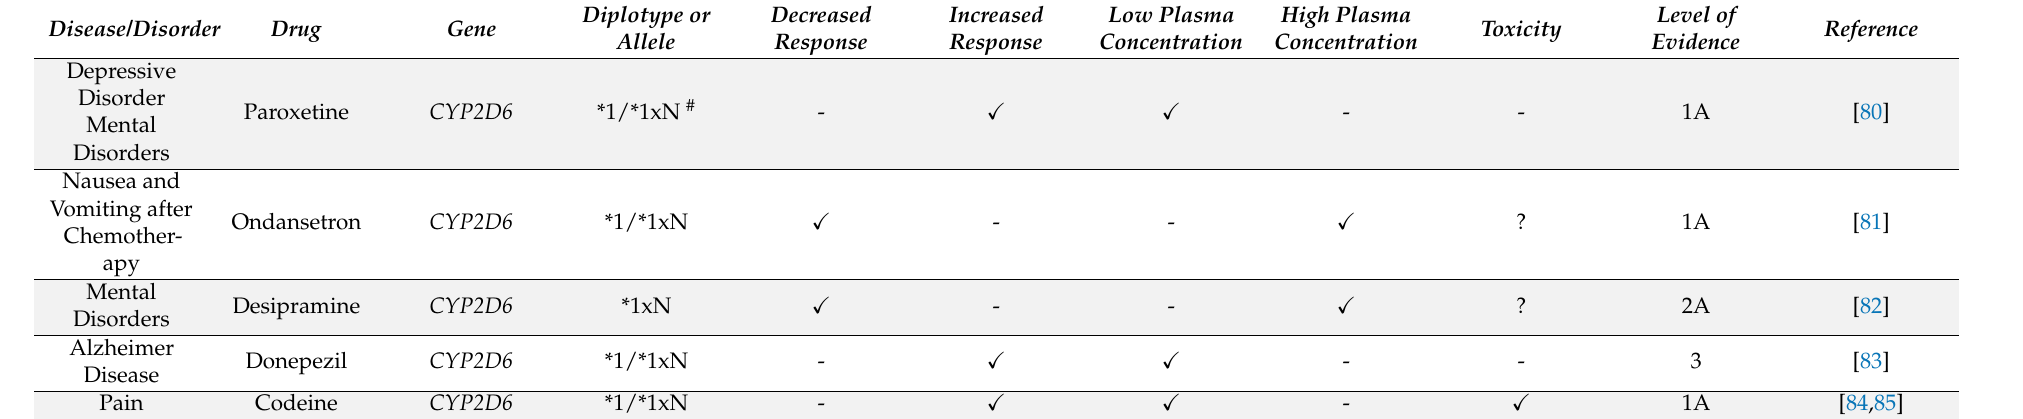
Table 4. Examples of different outcomes for one particular allele/diplotype of CYP2D6 in different disorders and